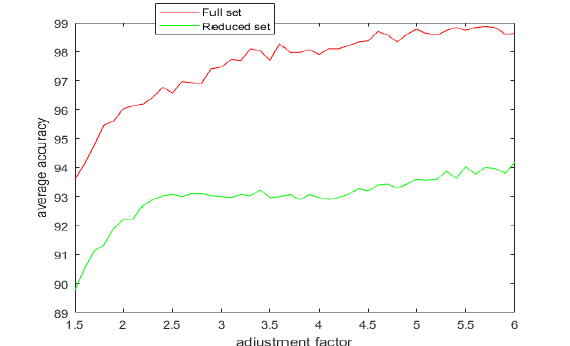
Figure 12. The average accuracy versus the adjustment factor for the full and the reduced artificially generated